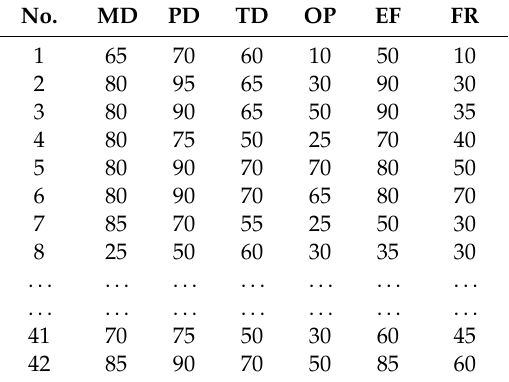
Table 6. Subjective workload evaluation results using the NASA-TLX